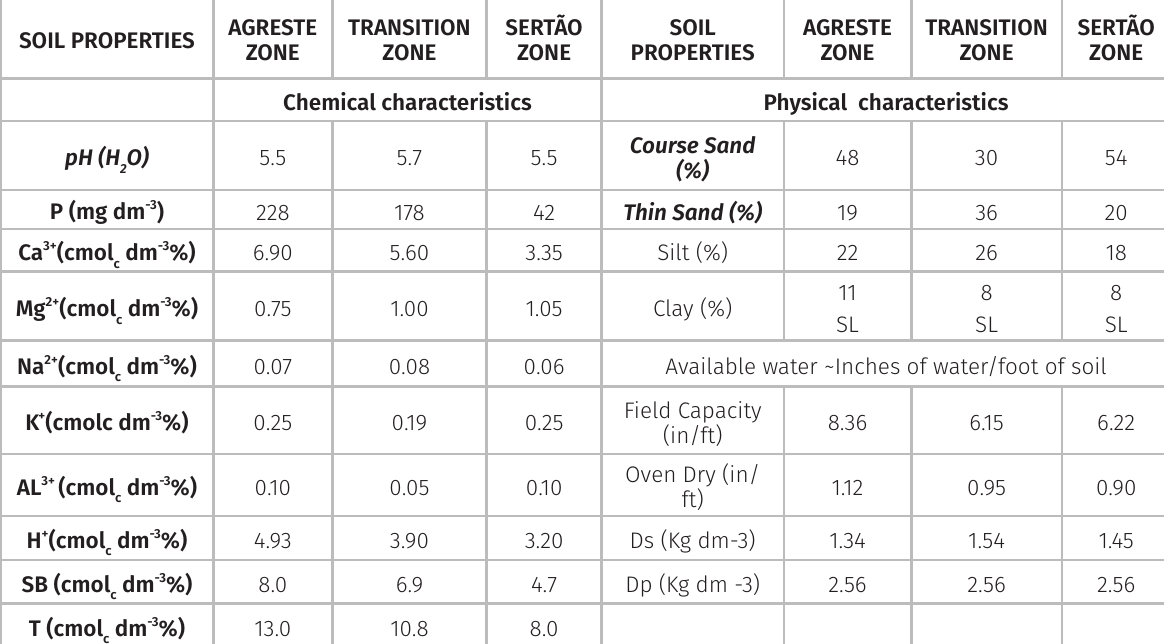
Table I. Chemical and Physical characteristics of the soil sampled by each mesoregion the state of Pernambuco. SOIL